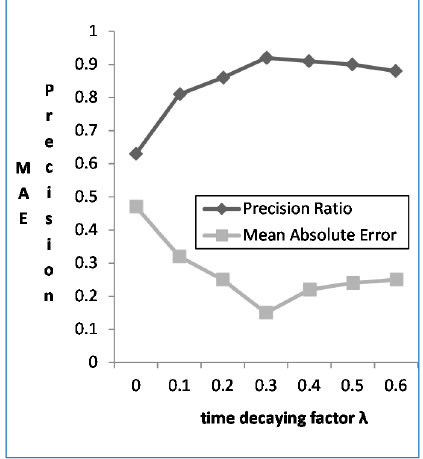
Figure 5. The Precision and MAE based on the different value of λ .